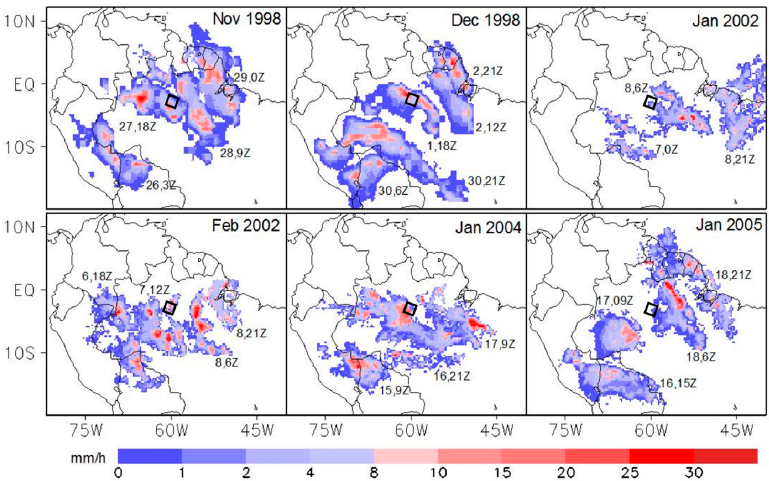
Figure 6. The position of southerly squall lines in the Amazon at different times obtained using TRMM3h data. The Landsat tile of the study area is also shown. The numbers in the Figures (e.g., 6, 18 Z) indicate the day of the month, and the hour (in Coordinate Universal Time, Z).